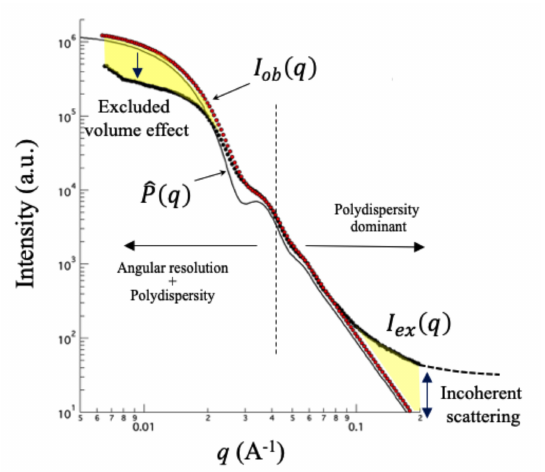
Figure 12. Scatteringobtained forSiO 2 microsphere, for examiningthe q -resolution. I ex ( q ) (black symbol) is the scattering profile experimentally determined. ˆ P ( q ) is smeared by the size distribution of spheres given by Equation (23) and I ob ( q ) is smeared by both size distribution and instrument angular resolution. The broken line is a guide for the eye showing incoherent